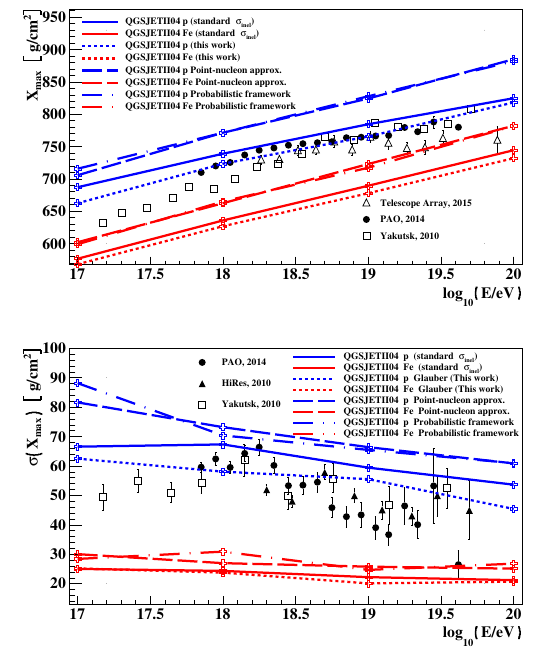
Figure 3. (top): Position of X max simulated using QGSJETII-04 model with di ff erent σ inel . Results for our Glauber calculations (dotted line) are compared with point-nucleon and probabilistic approximations (dashed lines) and original σ inel in QGSJETII- 04 model (solid line), (bottom): σ parameter of obtained X max